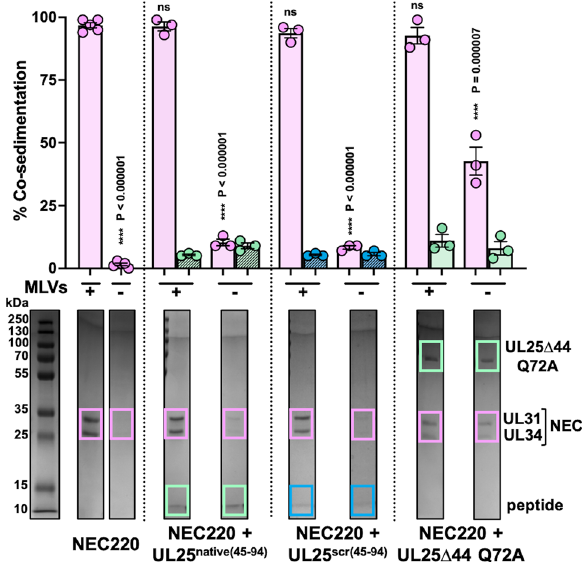
Figure 5. Peptides do not block membrane binding by the NEC. Co-sedimentation of NEC220 alone and in the presence of either UL25 native(45–94) , UL25 scr(45–94) , or UL25∆44 Q72A was assessed by a co-sedimentation assay in the presence and absence of MLVs. The amount of co-sedimentation was quantified with Coomassie staining. Bands from representative gels (full gel images are shown in Supplementary Fig. 1) used for quantification are boxed and colored as follows: pink—NEC (UL31: 34 kDa and UL34: 25 kDa); green—either UL25 native(45–94) (5 kDa) or UL25∆44 Q72A (57 kDa); blue – UL25 scr(45–94 ) (5 kDa). Each experiment was done in three biological replicates, each consisting of two technical replicates. Symbols represent average binding efficiency of each biological replicate. Bars show the mean of three biological replicates, with error bars representing the standard error of the mean. Significance compared to NEC220 in the presence of MLVs was calculated using an unpaired t -test. **** P value < 0.0001.